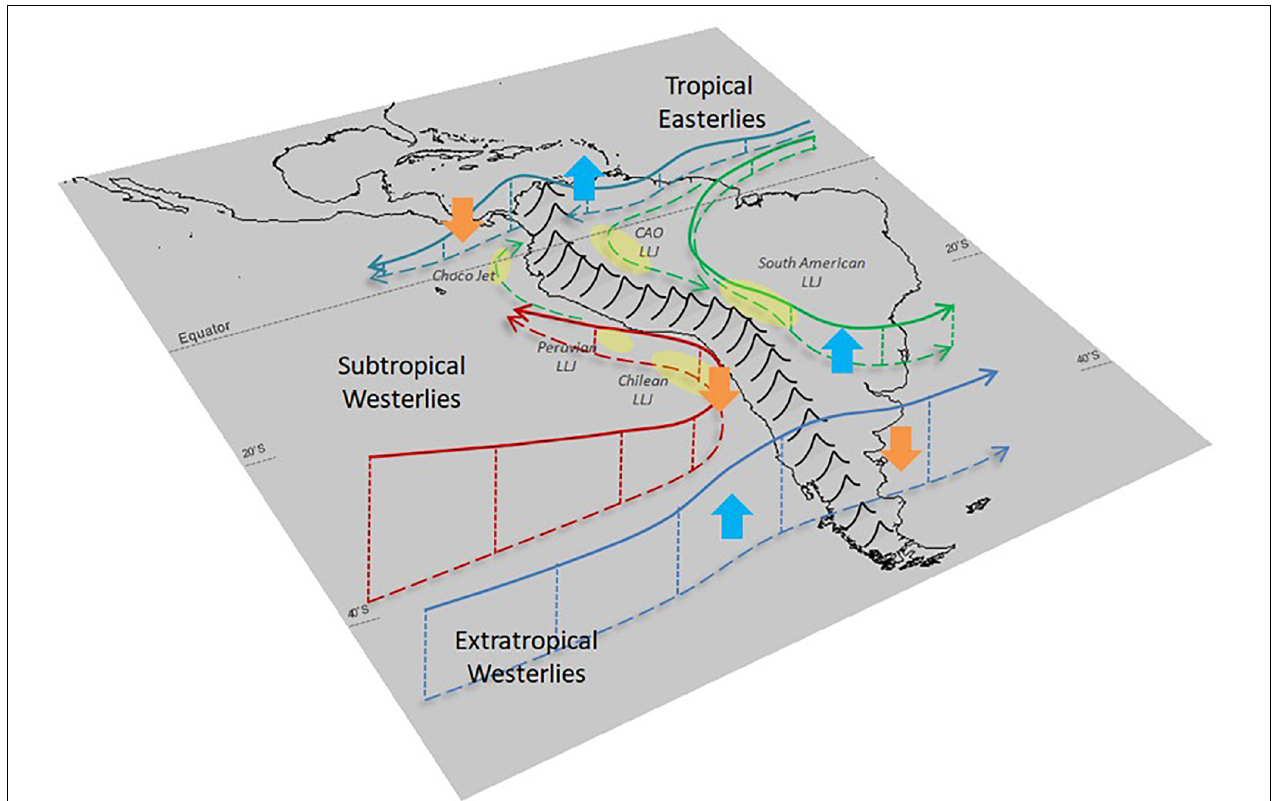
FIGURE 6 | Schematic figure of South America depicting the principal LLJs at both sides of the Andes